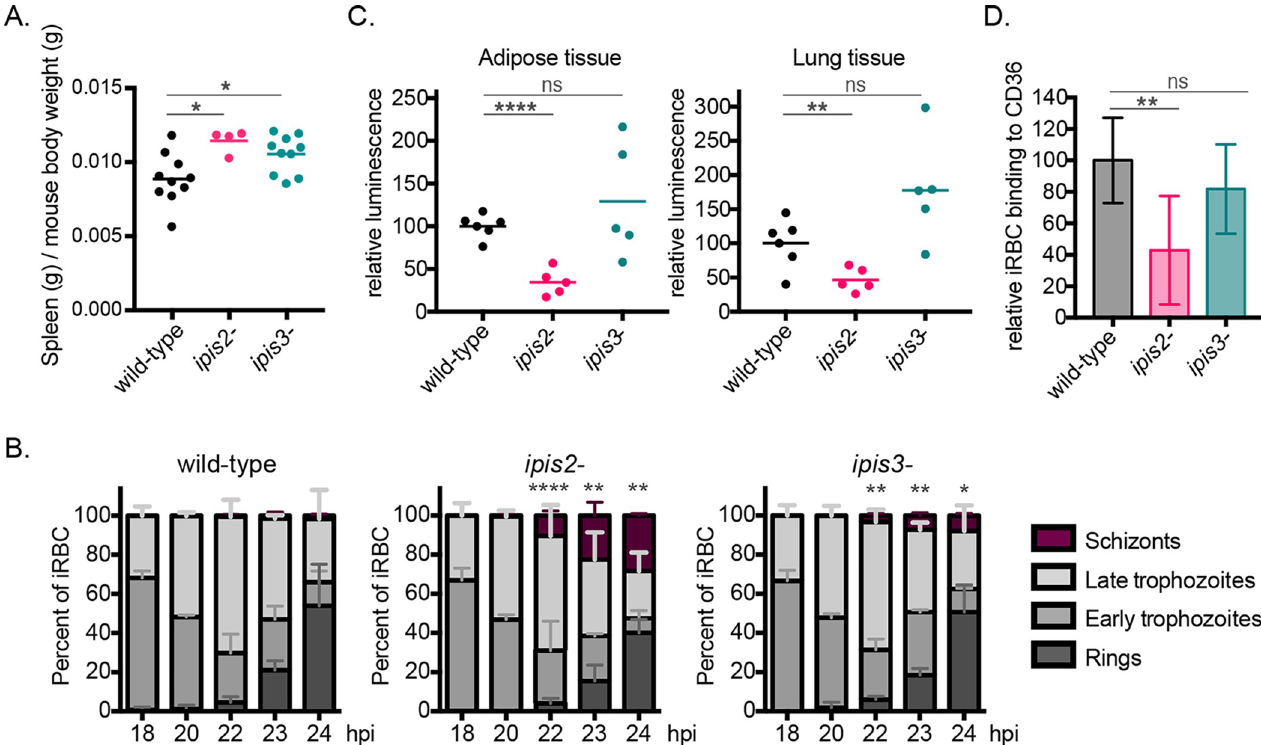
Fig 5. IPIS2 contributes to efficient sequestration of schizonts from the peripheral circulation. A) ipis2- or ipis3- infection increases spleen weight more than wild-type P . berghei infection. Mice were infected with sporozoites of either wild type (n = 10), ipis2- [GFP-Luc; PyrS] (n = 4), or ipis3- [GFP-Luc; PyrS] (n = 10) lines, and 8 days after infectionthe spleens were dissected and weighed. The spleen weights were plotted as ratios to mouse body weight. � p < 0.05, unpaired two-tailed t- test. B) The absence of IPIS2 or IPIS3 resulted in increased schizonts in peripheral blood compared to wild-type P . berghei during synchronous infections. Mice were infected with P . berghei schizonts(wild-type, ipis2- [GFP-Luc; PyrS] or ipis3- [GFP-Luc;PyrS]) and the parasite stages detected in peripheralblood smears were quantified at the indicated time points following infection. n = 5 mice in three experimental replicates. Statistical annotations ( � p < 0.05, �� p < 0.01, ��� p < 0.005) refer to percent of schizonts in the transgenicline in comparison to the wild-type line at the indicated time points, unpaired two-tailed t- test. C) Tissue-associated parasite materialwas assessed by luminescencein homogenized tissues 23 hours after infection with P . berghei schizonts (wild-type Pb GFP-Luc, ipis2- [GFP-Luc; PyrS] or ipis3- [GFP-Luc; PyrS]). Values are normalized to organs from wild-type-infected mice. �� p < 0.01, ���� p < 0.0001,ns: not significant, unpaired two-tailed t-test. D) Red blood cells infected with IPIS2-deficient P . berghei do not bind efficiently to CD36-expressing CHO cells. Schizonts were incubated with CHO cells and the number of infected-red blood cells bound per cell was quantified.The backgroundbinding to control CHO cells was subtracted, and the values were normalized to wild-type-infected red blood cell binding. The depicted data comprises three experimental replicates with three technicalreplicates for each parasite line and CHO cell line. �� p < 0.01, ns: not significant, unpaired two-tailed t-test.